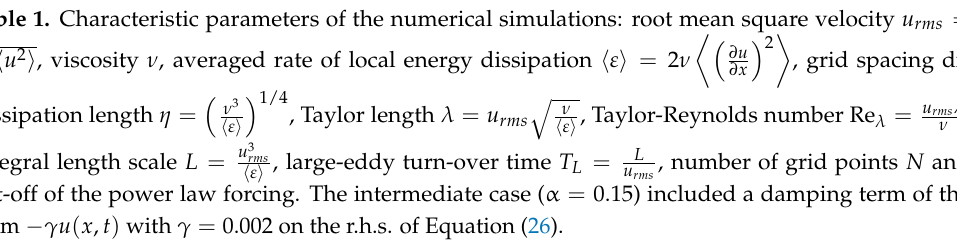
(cid:16) (cid:17) 1/4 ν 3 , Taylor length λ = u rms (cid:104) ε (cid:105) 3 rms , large-eddy turn-over time T L = L (cid:104) ε (cid:105)